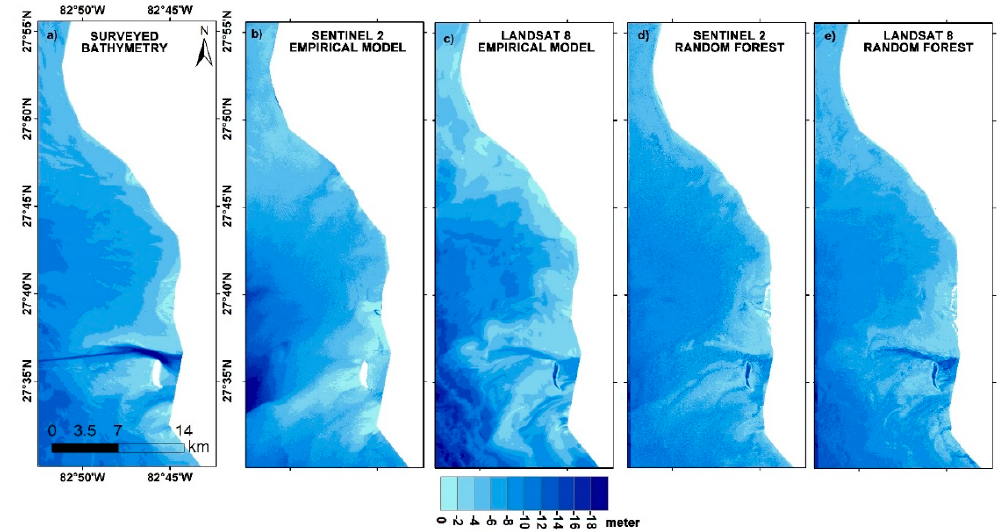
Figure 8. Bathymetric maps of Tampa Bay: ( a ) surveyed bathymetry; ( b ) Sentinel-2 derived bathymetry from empirical approach; ( c ) Landsat-8 derived bathymetry from empirical approach; ( d ) Sentinel-2 derived bathymetry from random forest; ( e ) Landsat-8 derived bathymetry from random forest.